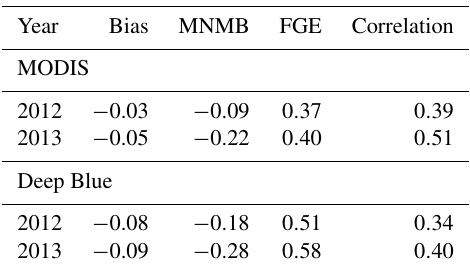
Table 2. Mean statistics of the comparison between the MODIS AOD and the MOCAGE simulation for the years 2012 and 2013 over the budget domain.